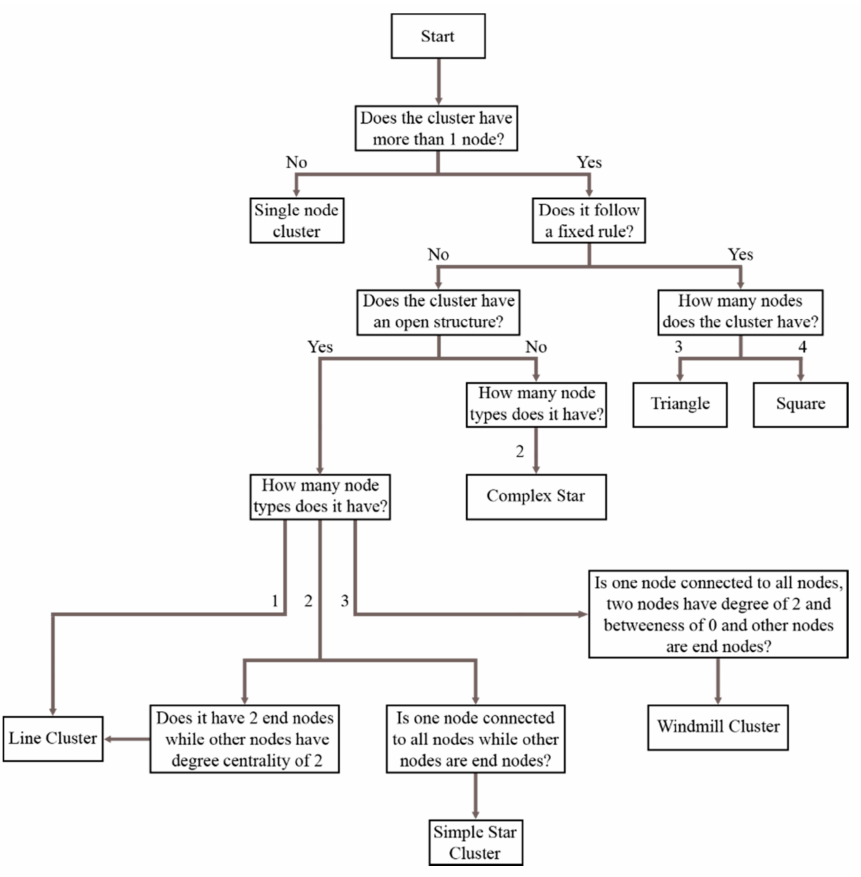
Figure 6. The cluster classification process. If a cluster is not assigned to any of the proposed classes, it is treated as a random cluster, examples given in Figure